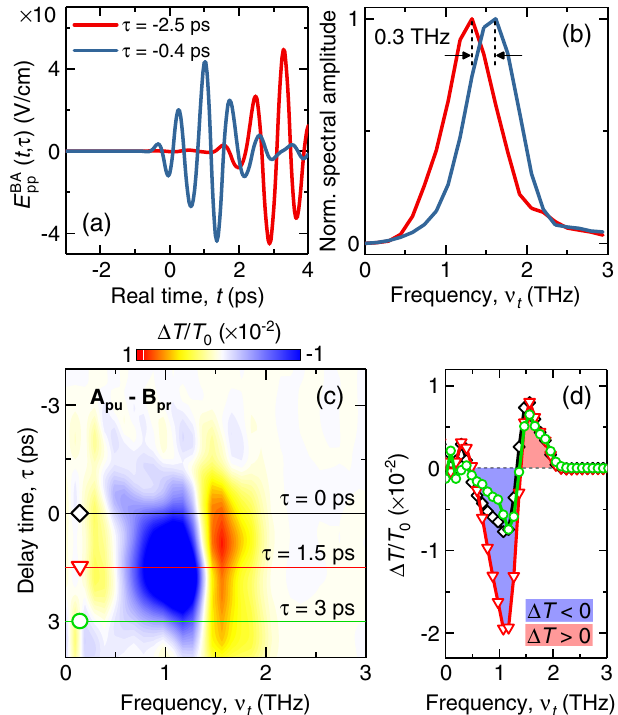
ð t; τ Þ from Fig. 5(d) for two different FIG. 6. (a) Traces of E BA pp delay times and (b) the corresponding spectra obtained by 1D ð ν ; τ Þ . (d) Traces of Fourier transforms. (c) Contour plot of S AB t pp S AB ð ν ; τ Þ signals at three different delay times of 0 ps, 1.5 ps, t pp and 3 ps, indicated by the black, red, and green horizontal solid lines in panel (c). The blue and red shaded regions correspond to induced absorption ( Δ T < 0 ) and bleaching ( Δ T > 0 ), ð t; τ Þ along t in Fig. 5(d) at two different delay times: of E BA pp one at times when the two pulses are well separated (say, at τ ¼ − 2 . 5 ps) and the other when they are simultaneously present in the sample (say, at τ ¼ − 0 . 4 ps). These THz transients and the corresponding spectra are shown in Figs. 6(a) and 6(b), respectively. At τ ¼ − 0 . 4 ps, the sample